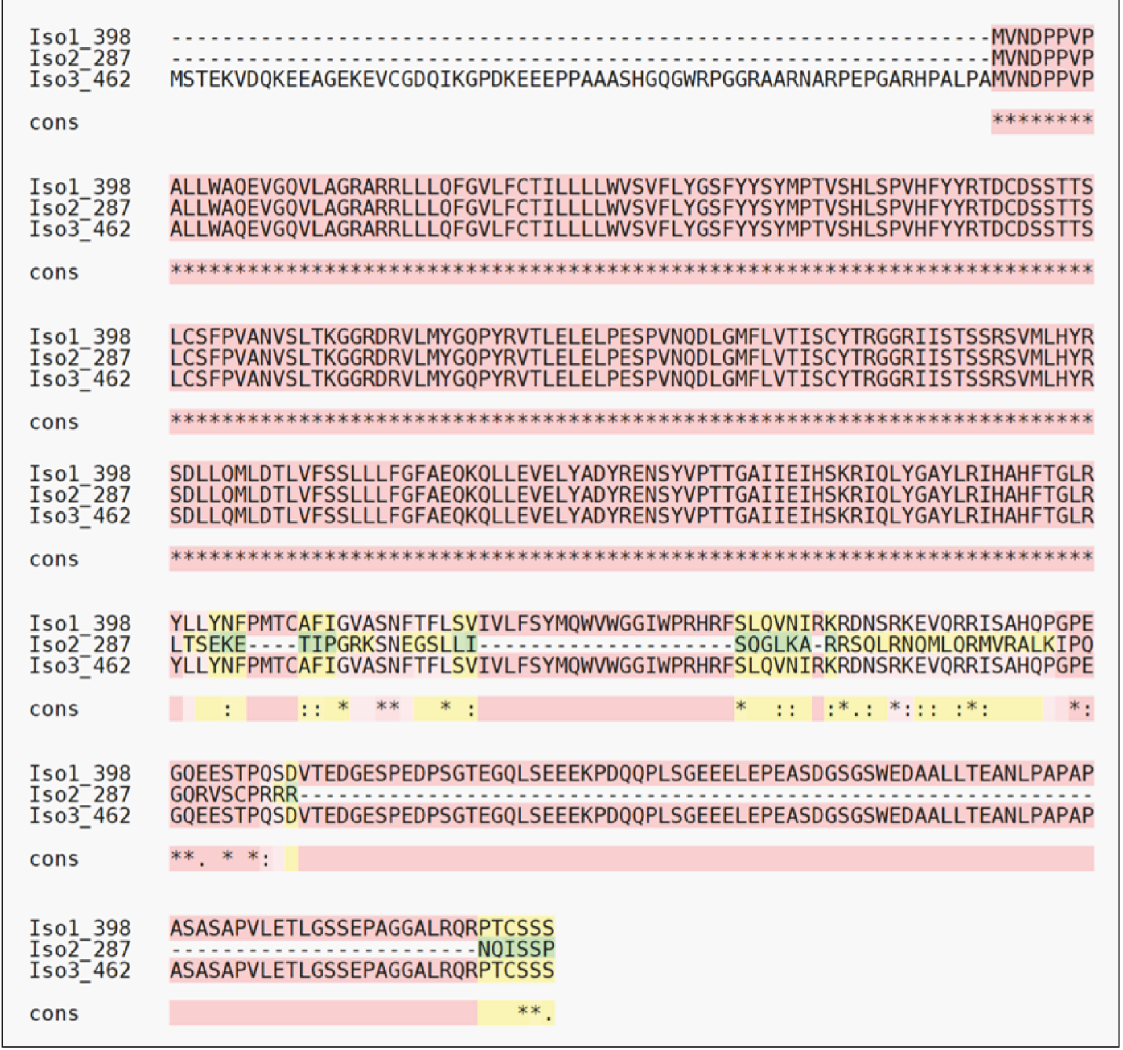
Figure 1: Human seipin isoforms. Multiple alignments of seipin isoforms were performed through T-Coffee [32]. Isoform 3 is the biggest with 462 amino acids, followed by 1 and 2 with 398 and 287 amino acids, respectively. UniProt [14] considers seipin isoform 1 as the canonical one. Pink color represents identical alignments; yellow corresponds to similar alignments; and green regions show different alignments. ∗ corresponds to an equal match and the differences are highlighted by . and : symbols. Cons: consensus sequence; Iso: isoform.